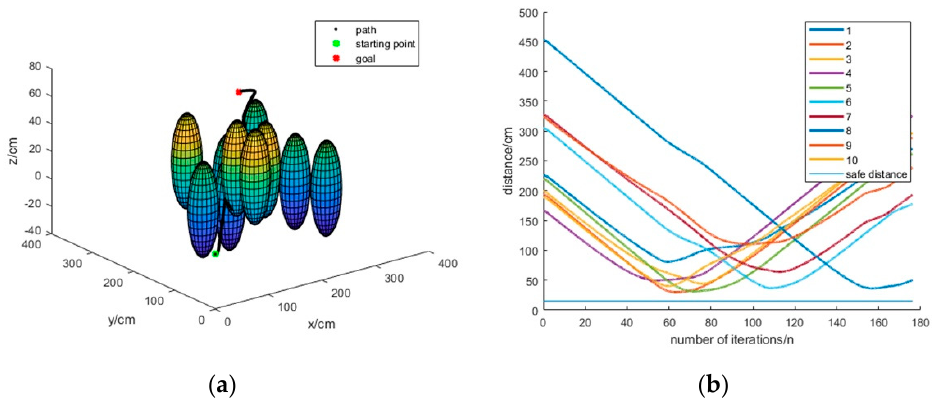
Figure 13. Case with time step in group 1. ( a ) Path planning of 3D map. ( b ) The distance from obstacles.